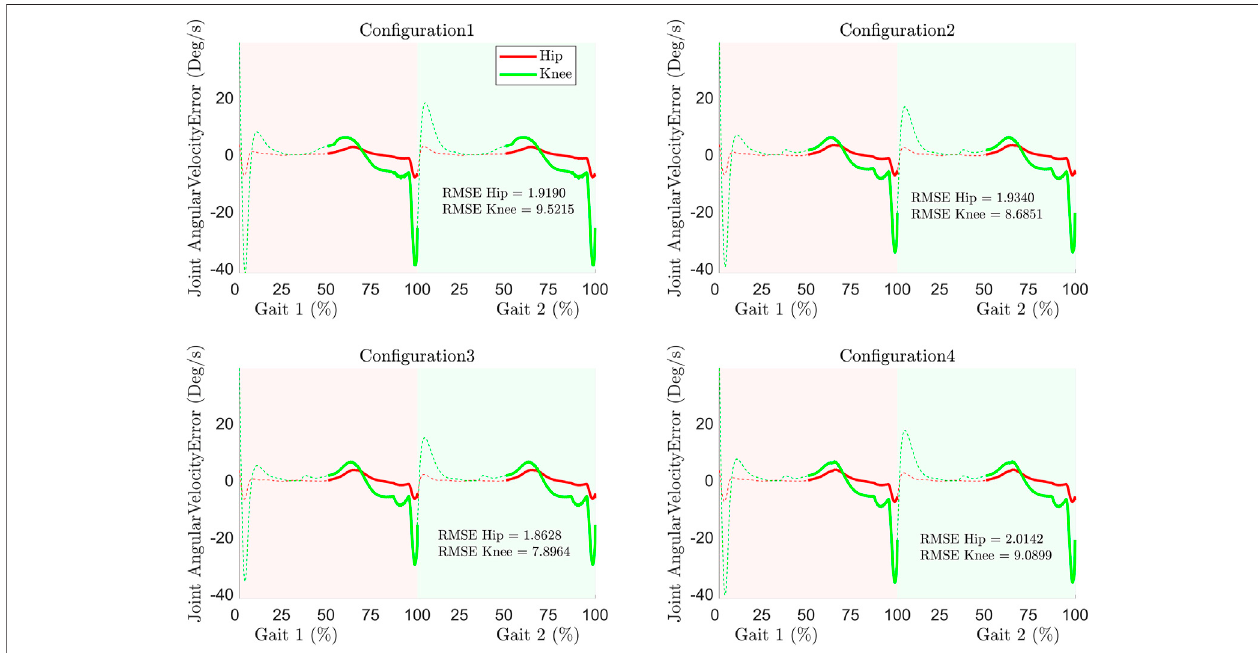
FIGURE 6 | Joint angular velocities error and RMSE during